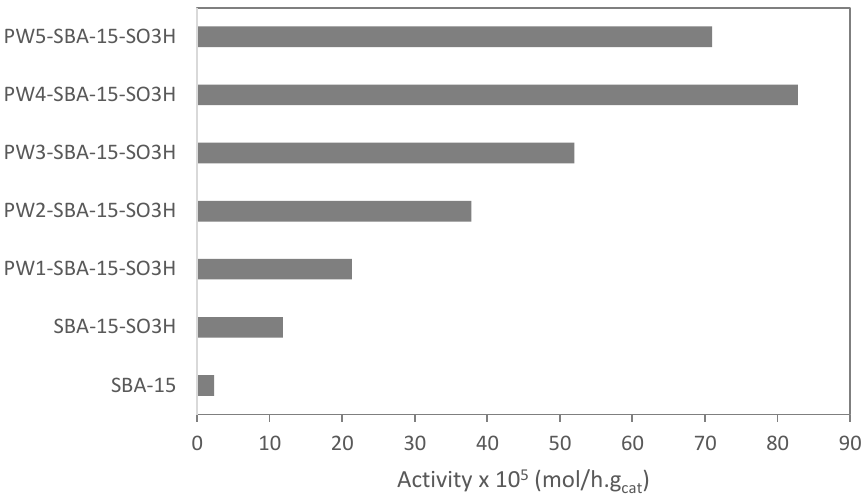
Figure 6. Camphene hydration over PW‑SBA‑15‑SO 3 H catalysts. Initial activity of the materials. ◦ Reaction conditions: T = 50 C; m cat = 0.482 g; V = 114 mL of aqueous acetone (1:1, V/V); n camphene